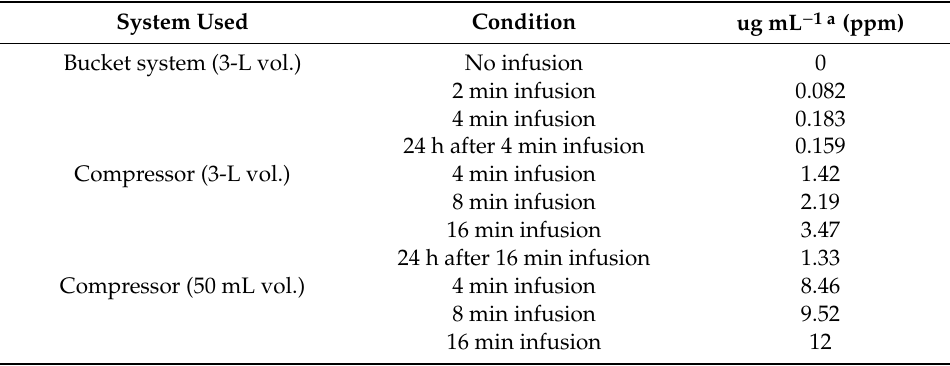
Table 1. Iodine residues following hand pump and compressor delivered iodine vapor. System